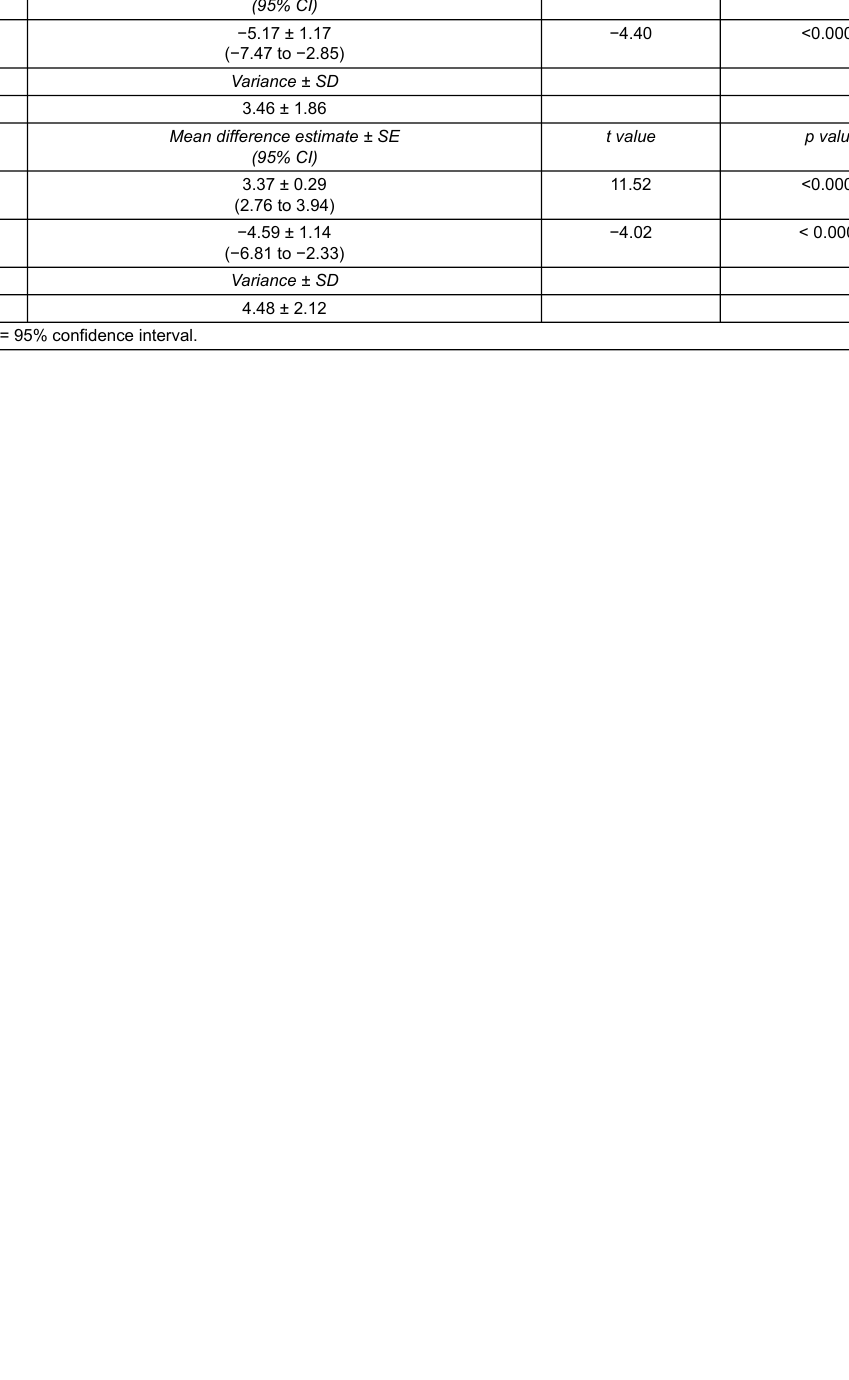
Table S2: Uni- and multivariable linear mixed model analysis adjusting for the number of comorbidities confirmed the effect of time period on patient age at the onset of the third wave of SARS-CoV-2 infections in Switzerland in comparison to the previous pandemic course. Multivariable analyses further revealed an effect of time period on the number of comorbidities when corrected for age. In these models, treatment centre was added as random effect and the p values of individual fixed effects were estimated using the Sat- terthwaite approximation. Univariable analysis, fixed